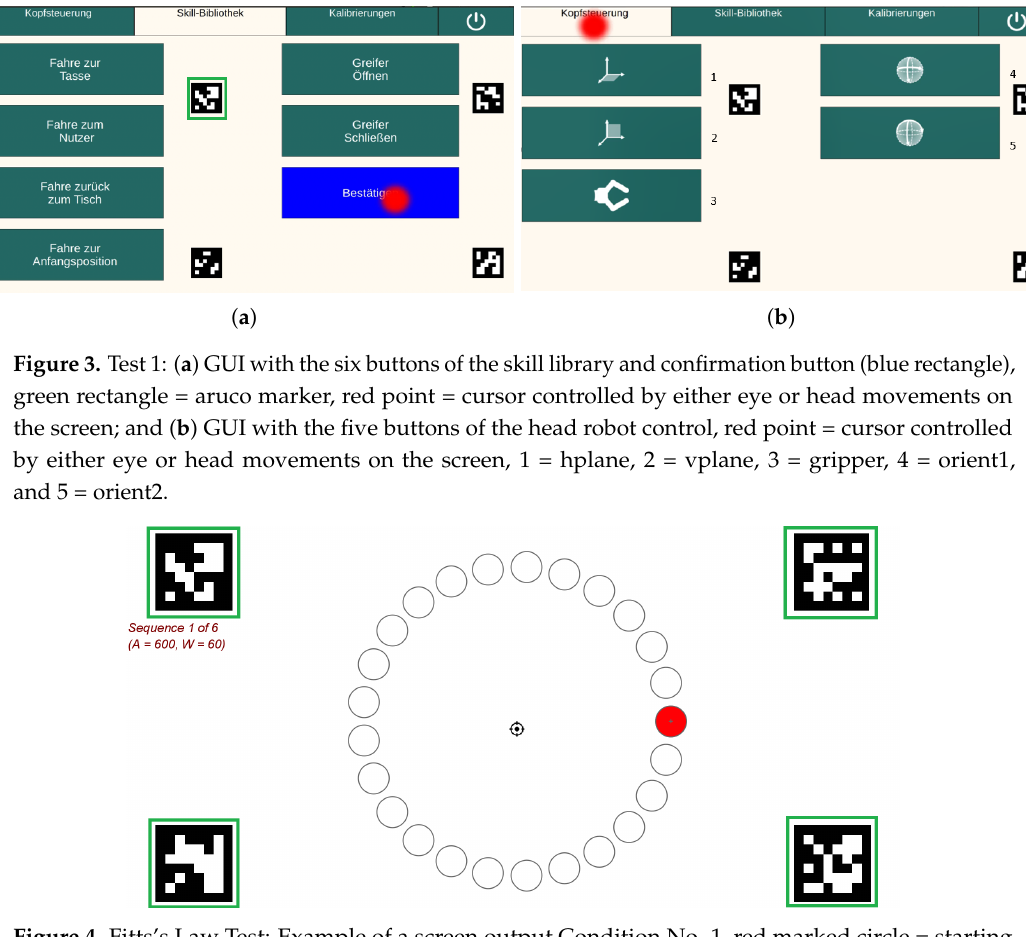
Figure 4. Fitts’s Law Test: Example of a screen output Condition No. 1, red marked circle = starting position, green rectangles = aruco marker. Table 1. The six conditions for the Fitts’s Law